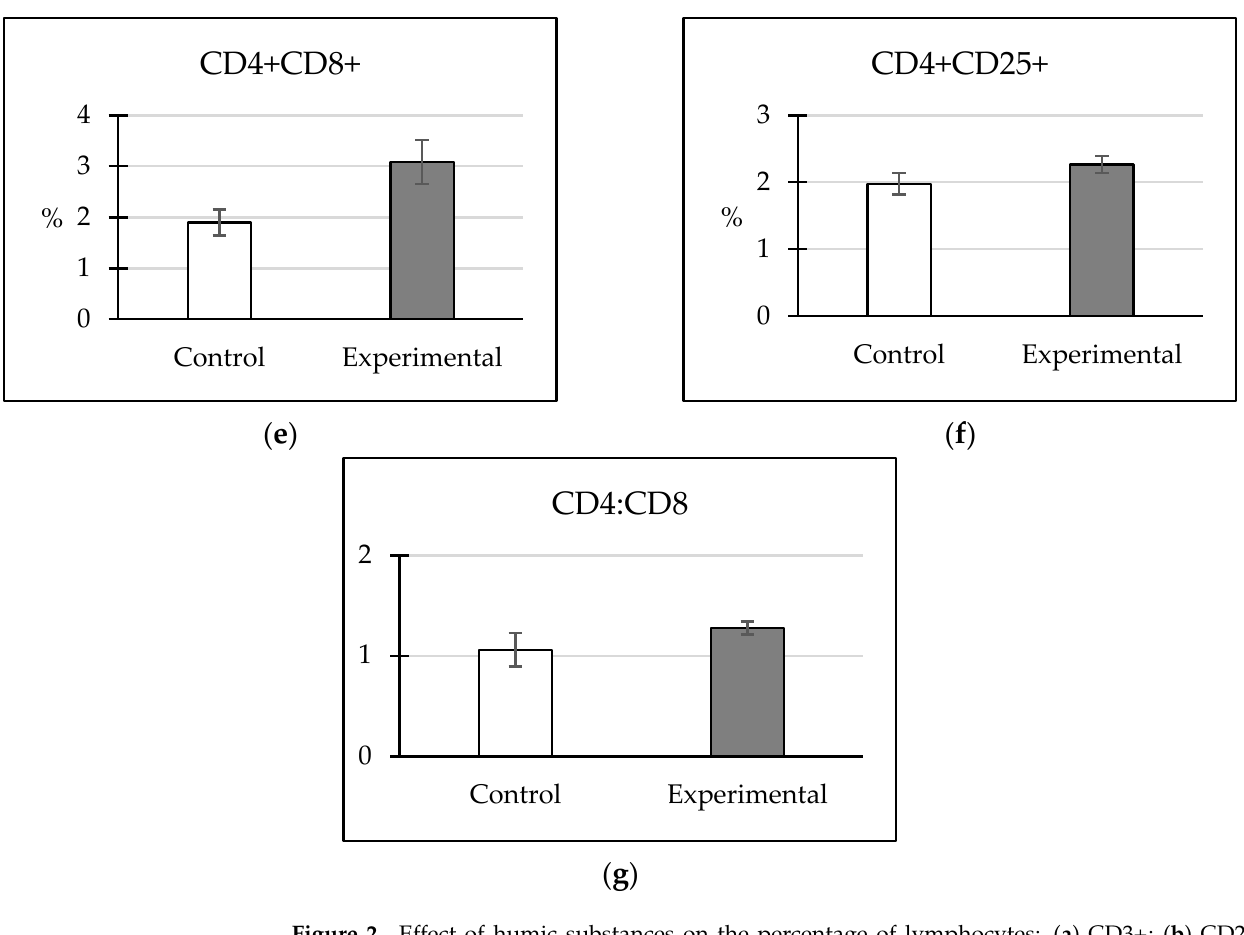
Figure 2. Effect of humic substances on the percentage of lymphocytes: ( a ) CD3+; ( b ) CD21+; ( c ) CD4+CD8-; ( d ) CD4-CD8+; ( e ) CD4+CD8+; ( f ) CD4+CD25+; and ( g ) ratio of CD4:CD8 lymphocytes in the blood of the piglets. Column labelled with asterisk is significantly different from the control (*** p ˂ 0.001).